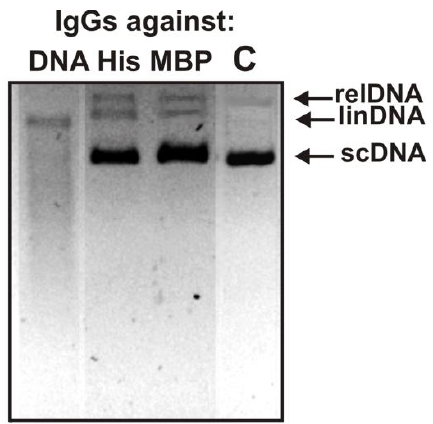
Figure 2. Analysis of the relative activity of IgGs against DNA, five different histones, and MBP in the hydrolysis of scDNA for 3 h. Designations of IgGs are shown in the